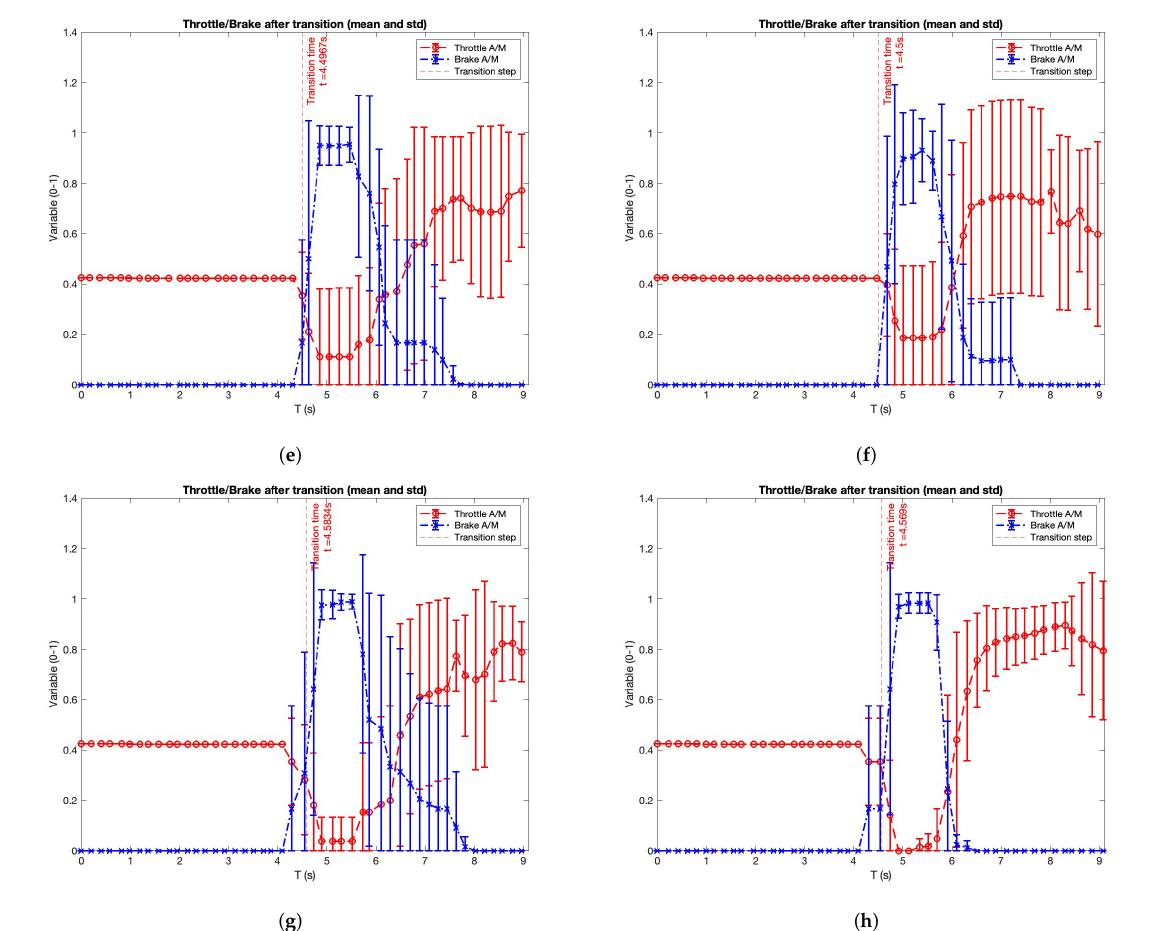
Figure 11. Throttle and brake analysis after transition (mean and standard deviation). Transitions are split into autonomous to manual (A/M). ( a ) Experiment: ACC. Driver attention: focus. ( b ) Ex- periment: ACC + passing. Driver attention: focus. ( c ) Experiment: ACC. Driver attention: using the mobile phone. ( d ) Experiment: ACC + passing. Driver attention: using the mobile phone. ( e ) Experi- ment: ACC. Driver attention: reading. ( f ) Experiment: ACC + passing. Driver attention: reading. ( g ) Experiment: ACC. Driver attention: talking to passenger. ( h ) Experiment: ACC + passing. Driver attention: talking to passenger.